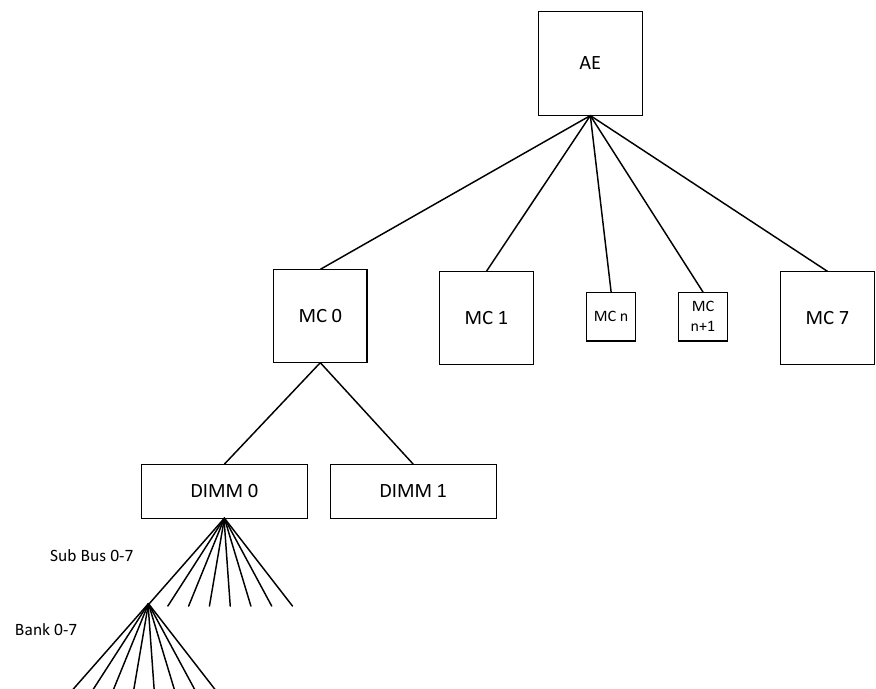
Figure 3. Memory hierarchy.